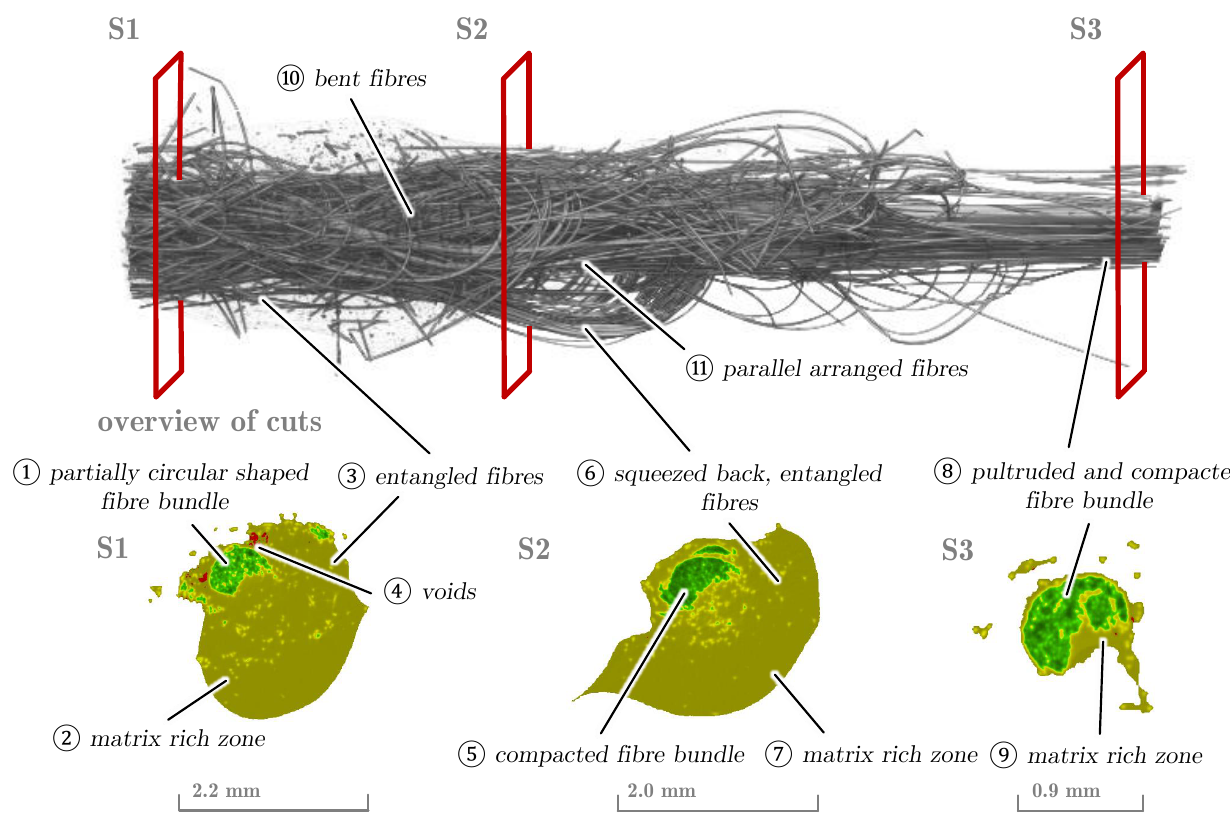
Figure 16. CT reconstruction data and section cuts of deformed GF-PP, D fe =